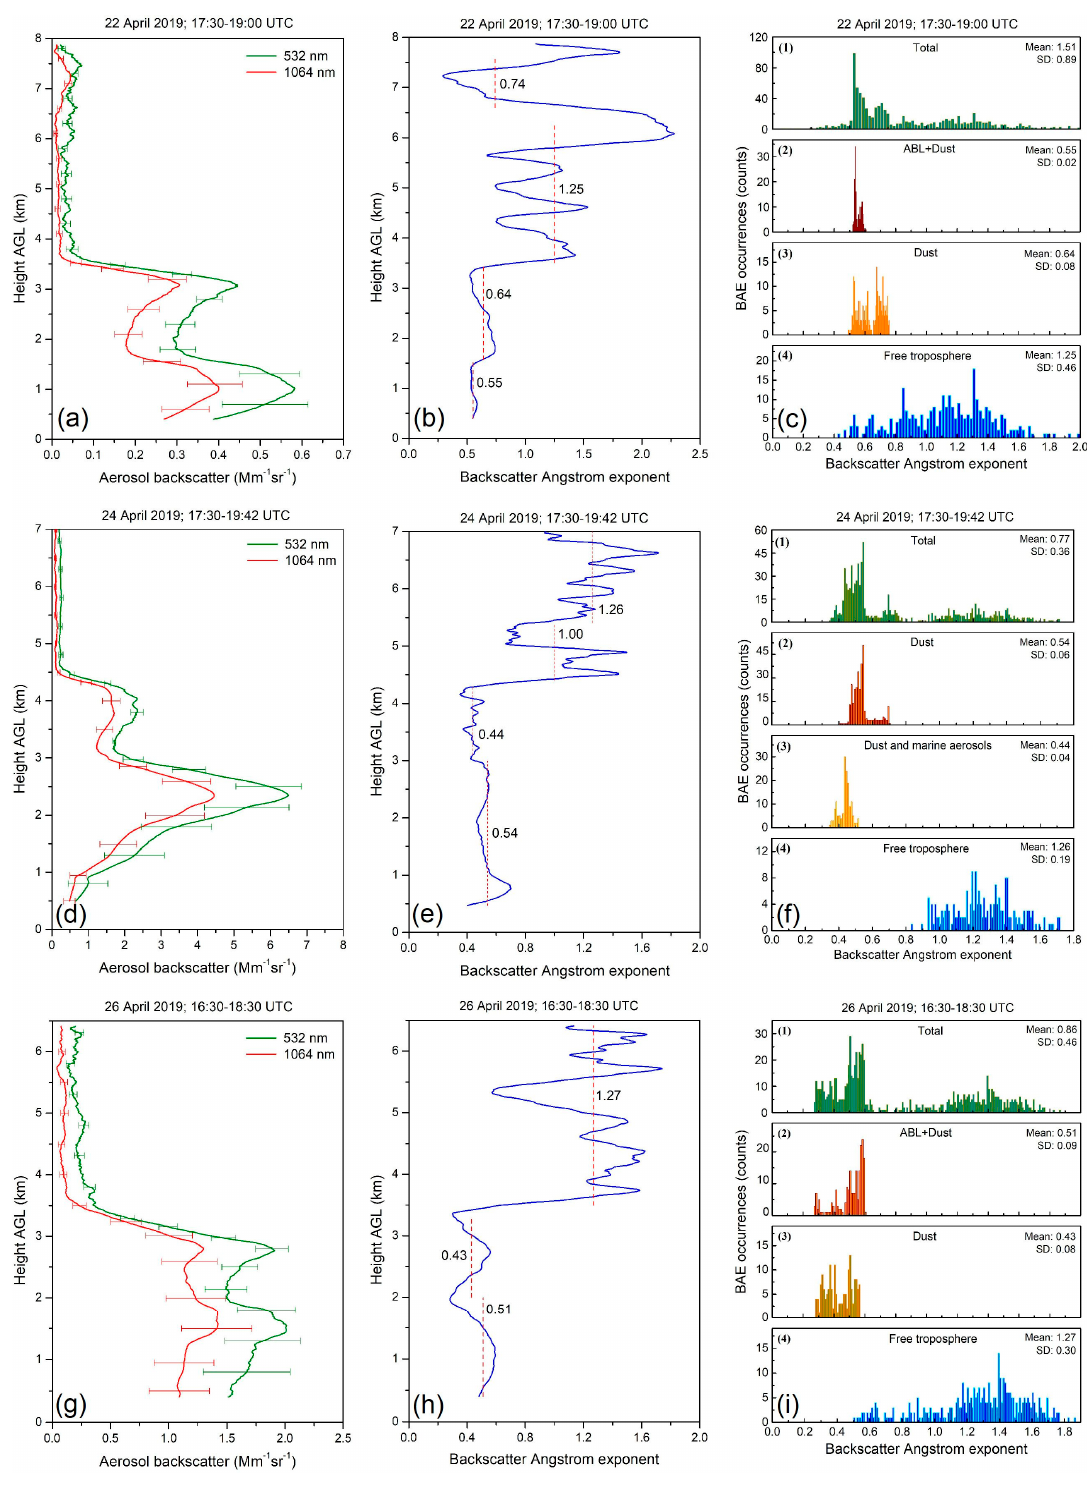
Figure 9. Time-averaged vertical profiles of the aerosol BSC at 532 nm and 1064 nm (left column) and corresponding BAE (middle column), together with frequency-count BAE distributions (right column) resulting from lidar measurements performed on ( a – c ) 22 April 2019, ( d – f ) 24 April 2019, and ( g – i ) 26 April 2019.